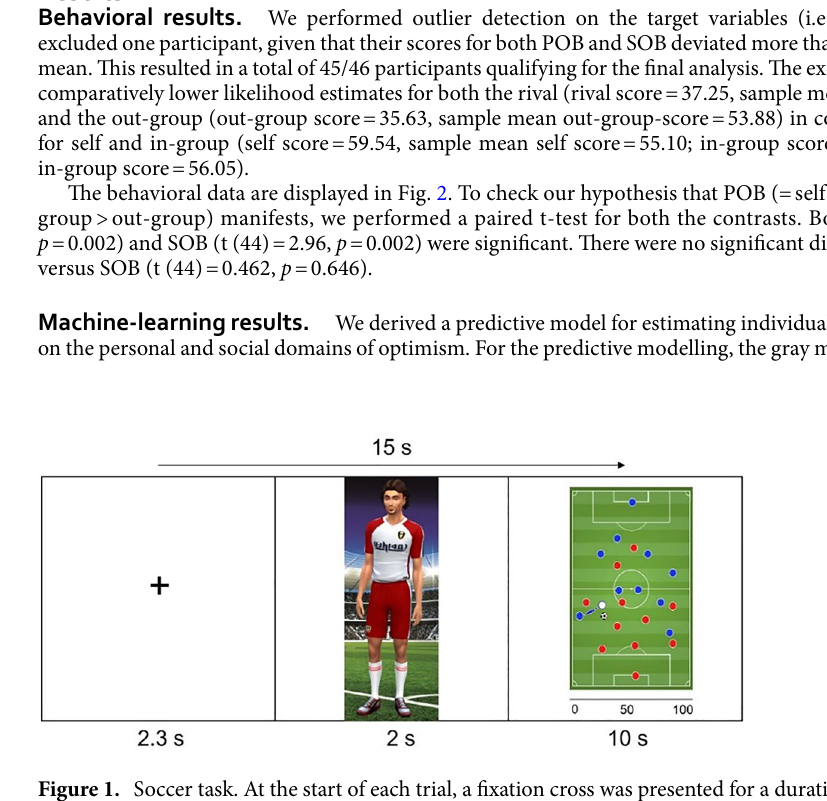
Figure 1. Soccer task. At the start of each trial, a fixation cross was presented for a duration of 2–3 s (variation due to jittering). Next, a player representing the self, rival, in-group, or out-group was displayed for 2 s. Subsequently, a soccer game scenario was presented for 10 s; in this latter phase participants estimated the likelihood for a successful pass (rating range 0–100%). Each trial lasted approximately 15